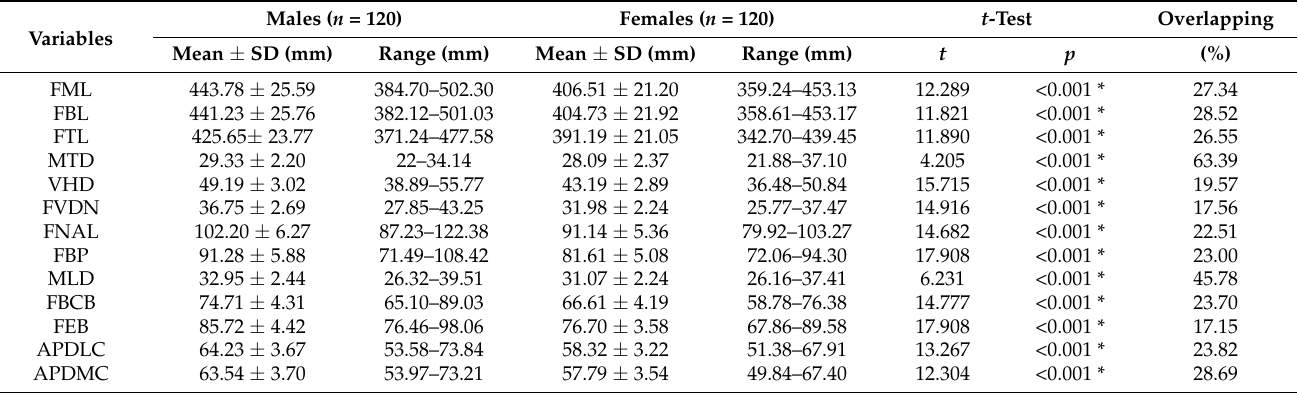
Table 1. Descriptive statistics with t -test results and overlapping percentages in the training